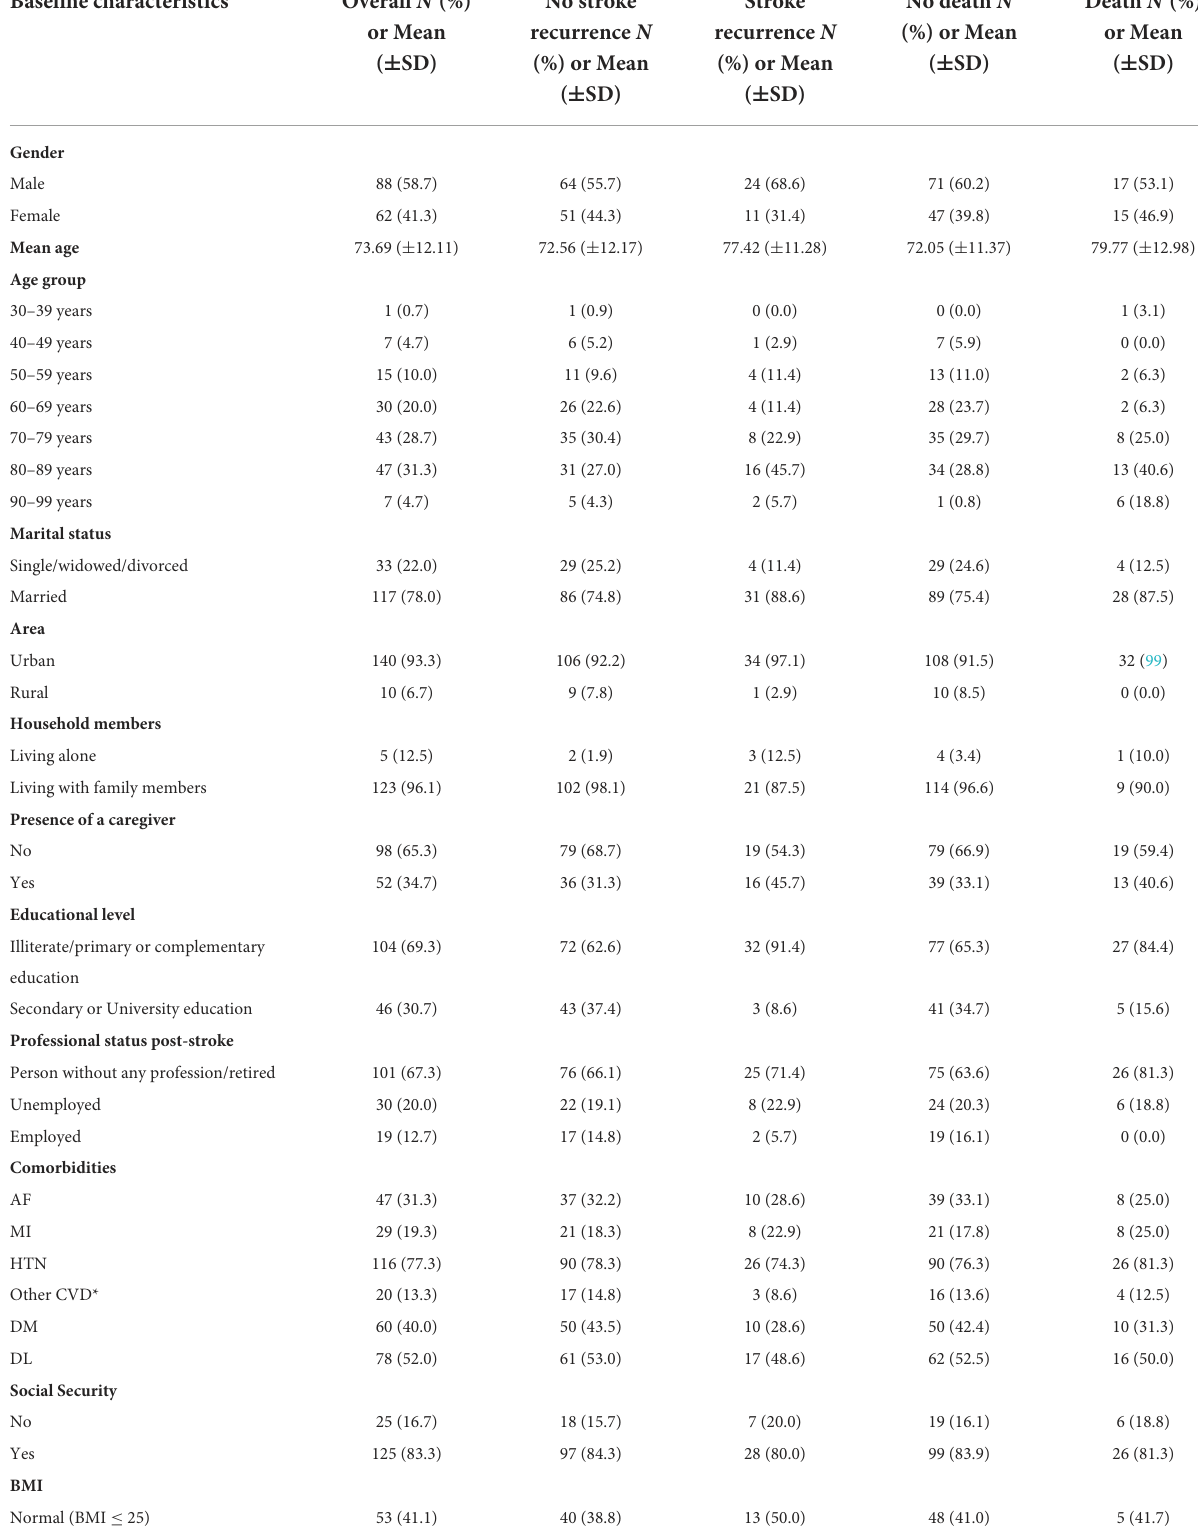
TABLE 1 Baseline characteristics of the study